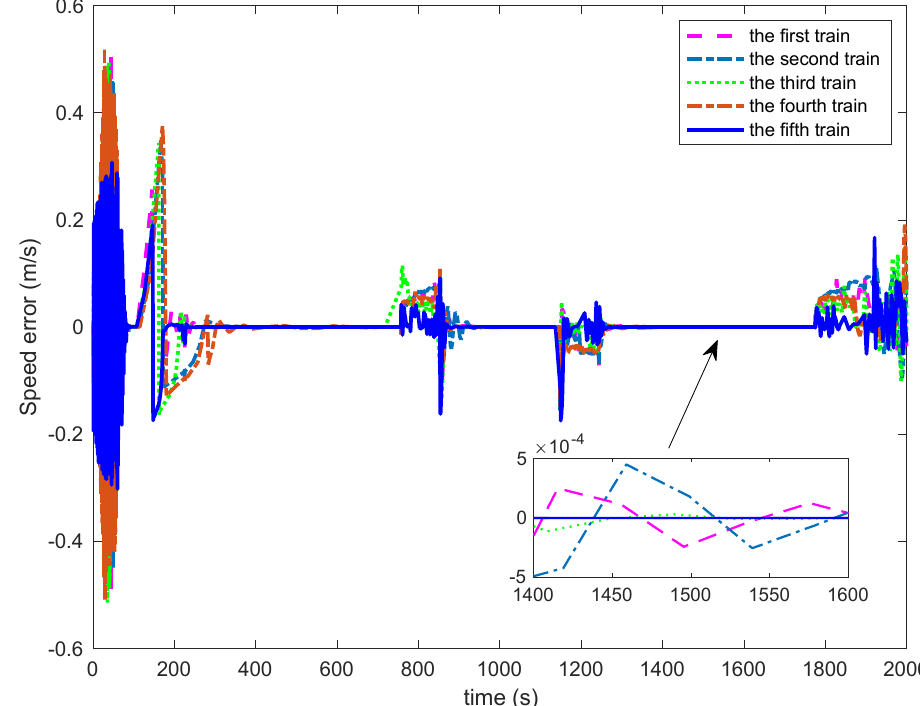
Figure 11. Speed tracking error curves for single-value learning.